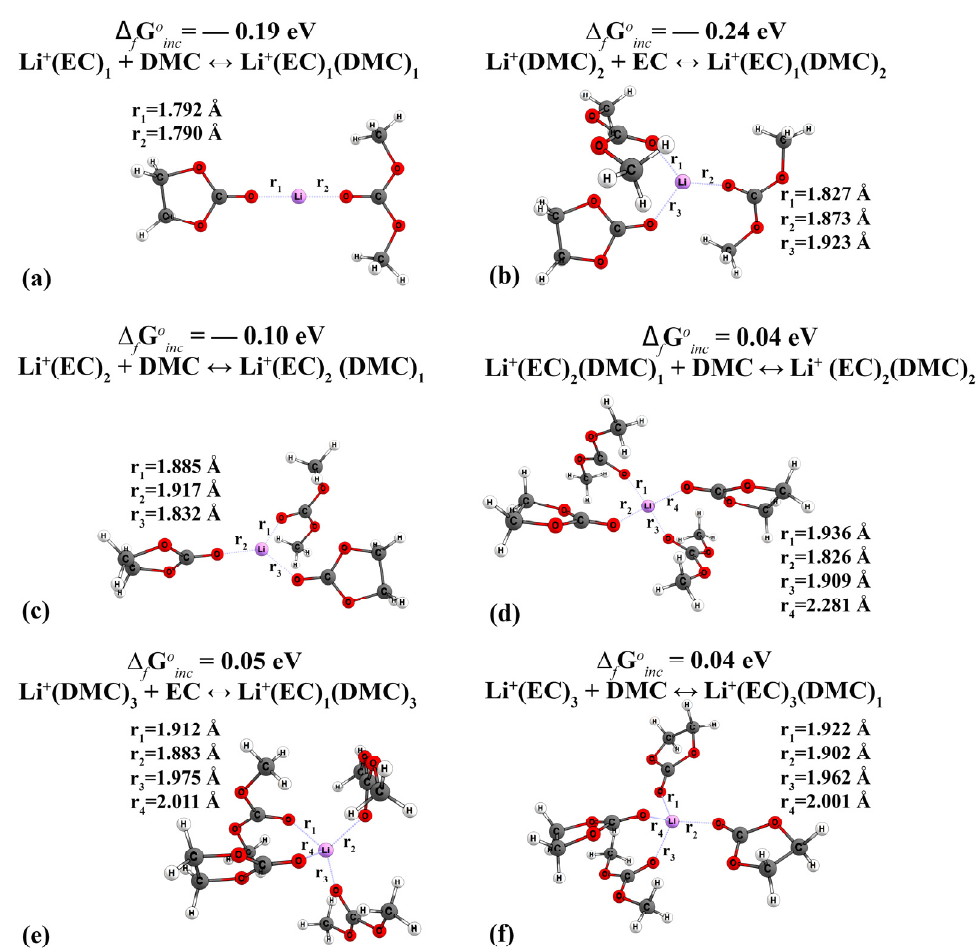
Figure 4. Geometric structure of mixed-type cationic complexes Li + (EC) n (DMC) n : ( a ) Li + (EC) 1 (DMC) 1 , ( b ) Li + (EC) 1 (DMC) 2 , ( c ) Li + (EC) 2 (DMC) 1 , ( d ) Li + (EC) 2 (DMC) 2 , ( e ) Li + (EC) 1 (DMC) 3 , ( f ) Li + (EC) 3 (DMC) 1 .